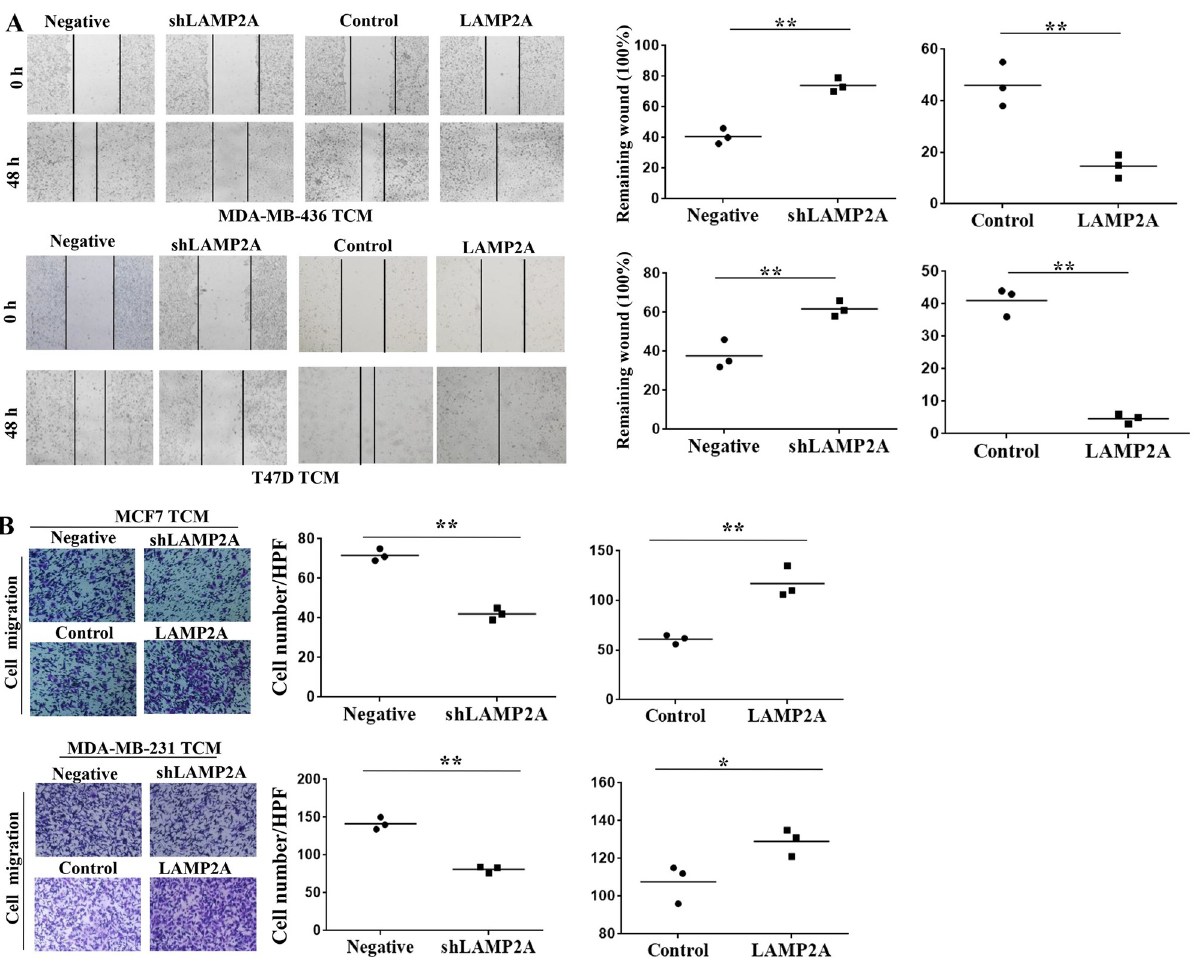
Fig 4. CMA promotes migration of HUVECs. (A) Wound-healing assay was used to detect the migration of HUVECs. After the wound scratch, the cells were cultured with TCM from MDA-MB-436 and T47D cells for 36 h and the size of the wound at indicated times was observed by microscope. (B) Transwell migration assay was used to determine the migration of HUVECs. HUVECs migrated to the lower chamber with TCM from MDA-MB- 231 and MCF7 were counted under a microscope. All values are representative of three different experiments; � P < 0.05, �� P <